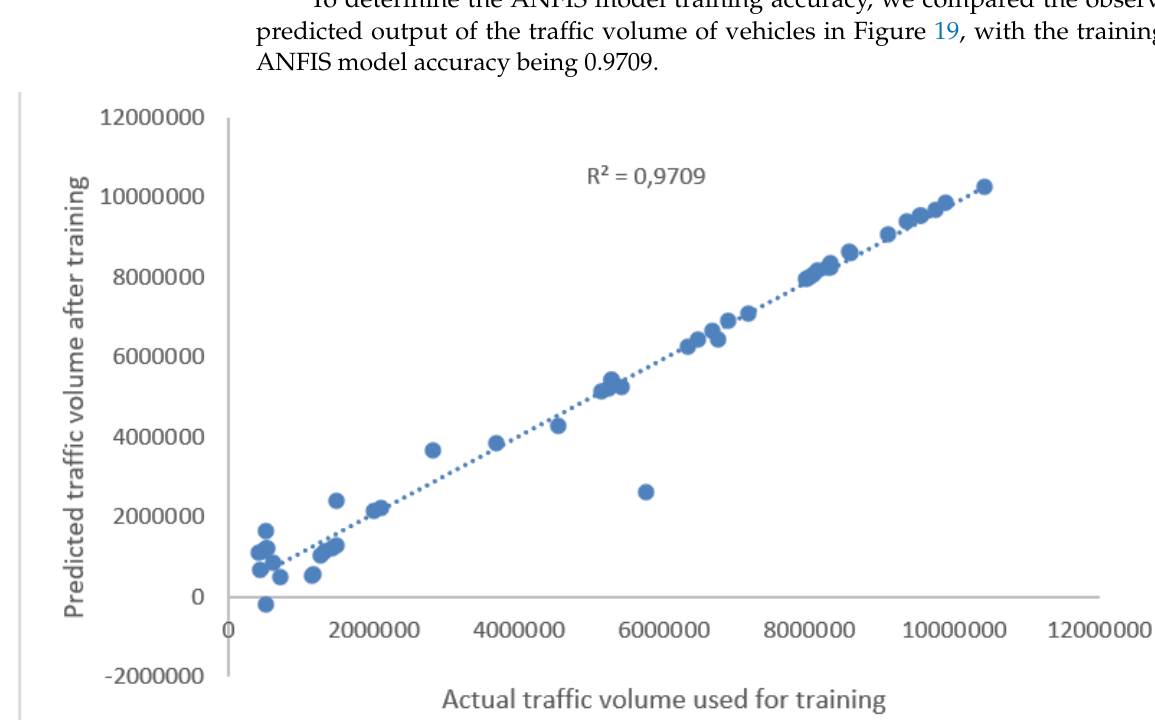
Figure 18. 3D image of the ANFIS model. (Input 1= time, input 2 = speed of vehicles, output = traffic volume).